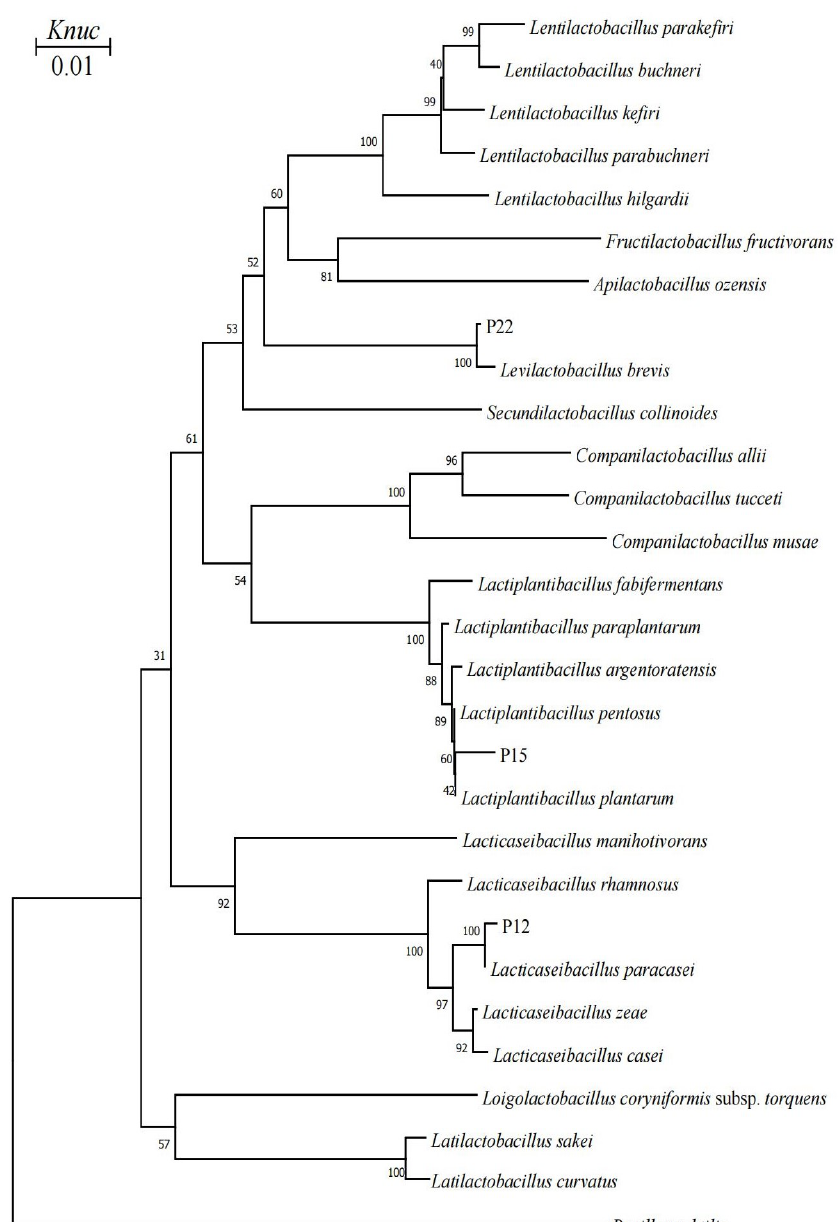
Figure 1. Phylogenetic tree showing the relative positions of rod-shaped LAB strains isolated from pineapple residue silage by the neighbor-joining method of complete 16S rRNA sequences. Bootstrap values for 1000 replicates are shown at the nodes of the tree. Bacillus subtilis is used as an outgroup organism. The bar indicates 1% sequence divergence. Knuc = nucleotide substitution